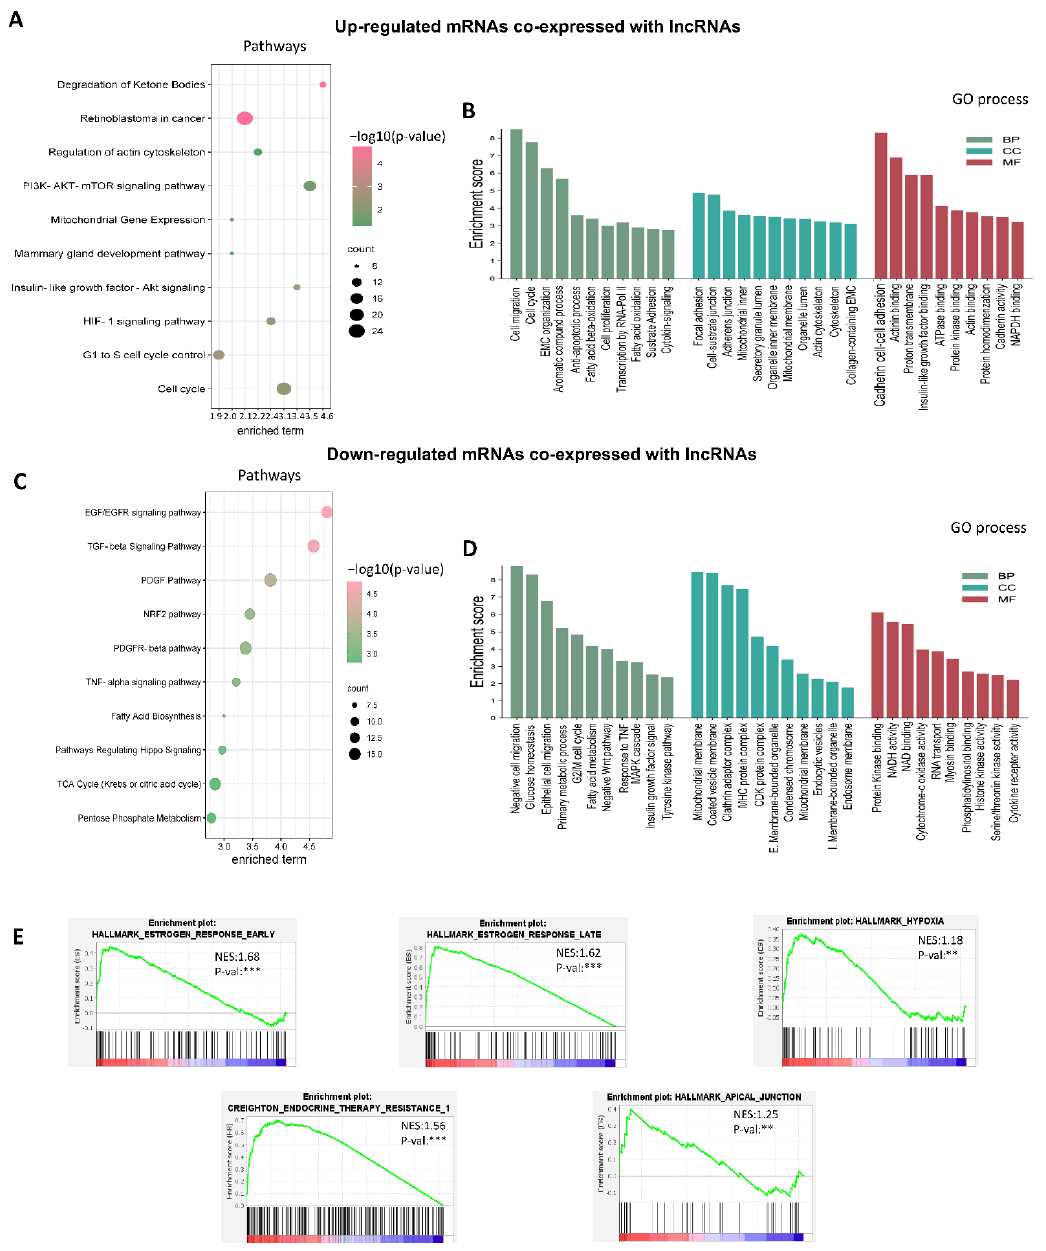
Figure 4. Analysis of biological functions related to mRNAs co-expressed with lncRNAs through Genetic Ontologies (GO), Pathways and Gene Set Enrichment Analysis. ( A , B ) Pathways and GO analysis of up-regulated mRNAs co-expressed with lncRNAs ( C , D ) Pathways and GO analysis of down-regulated mRNAs co-expressed with lncRNAs; BP (biological process), CC (cellular compartment), MF (molecular function) of GO analysis ( E ) GSEA analysis was done using mRNAs co-expressed with lncRNAs using datasets from both cancer hallmark and endocrine therapy resistance GSEA collections. Significant GSEA enrich processes (** p < 0.01, *** p < 0.001; NES ±